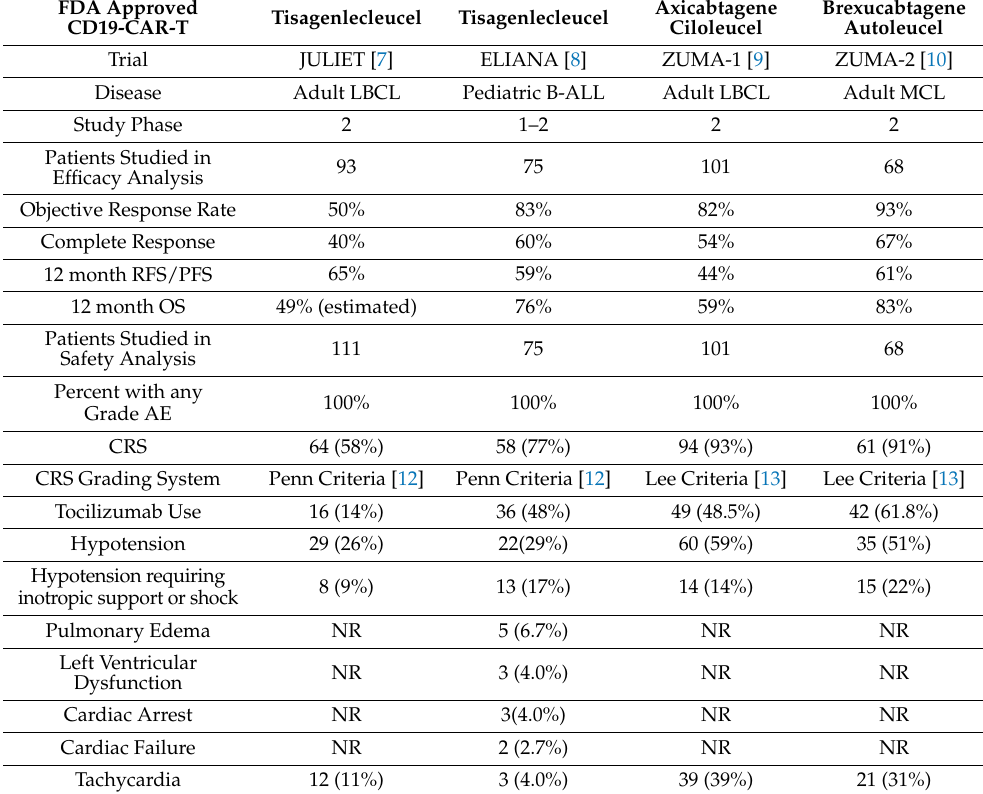
B-ALL: B-cell Acute Lymphoblastic Leukemia; RFS: Relapse Free Survival; PFS: Progression Free Survival; OS: Overall Survival; AE: Adverse Events; CRS: Cytokine Release syndrome; LBCL: Large B-cell Lymphoma; MCL: Mantle Cell